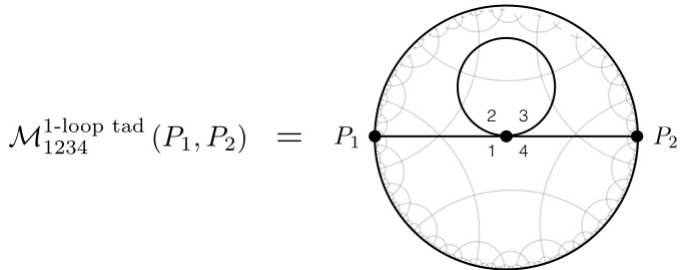
Figure 4. One-loop tadpole diagram M 1-loop tad generated by the quartic vertex (2.78) . The point 1234 split (cid:12)elds (cid:30) 1 and (cid:30) 4 are external, while (cid:30) 2 and (cid:30) 3 propagate in the loop. The other diagrams